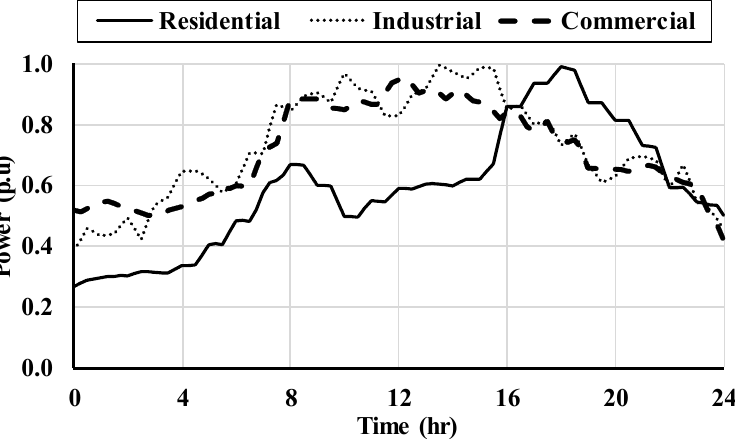
Figure 7. Classical loading profiles.